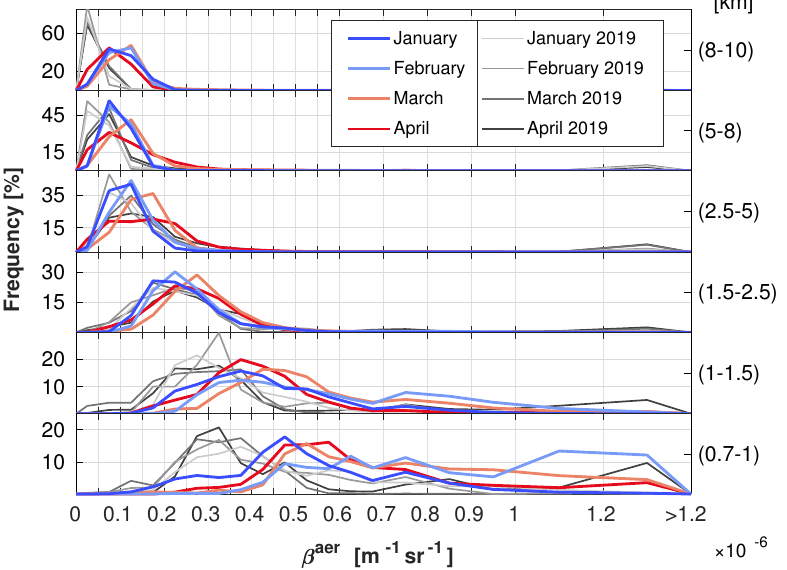
Figure 2. Frequency polygon of the backscatter coefficient β aer ( 532nm) for different altitude ranges (labels on the right side) and months (indicated by colors). As a reference, the data from [29] for 2019 are plotted in